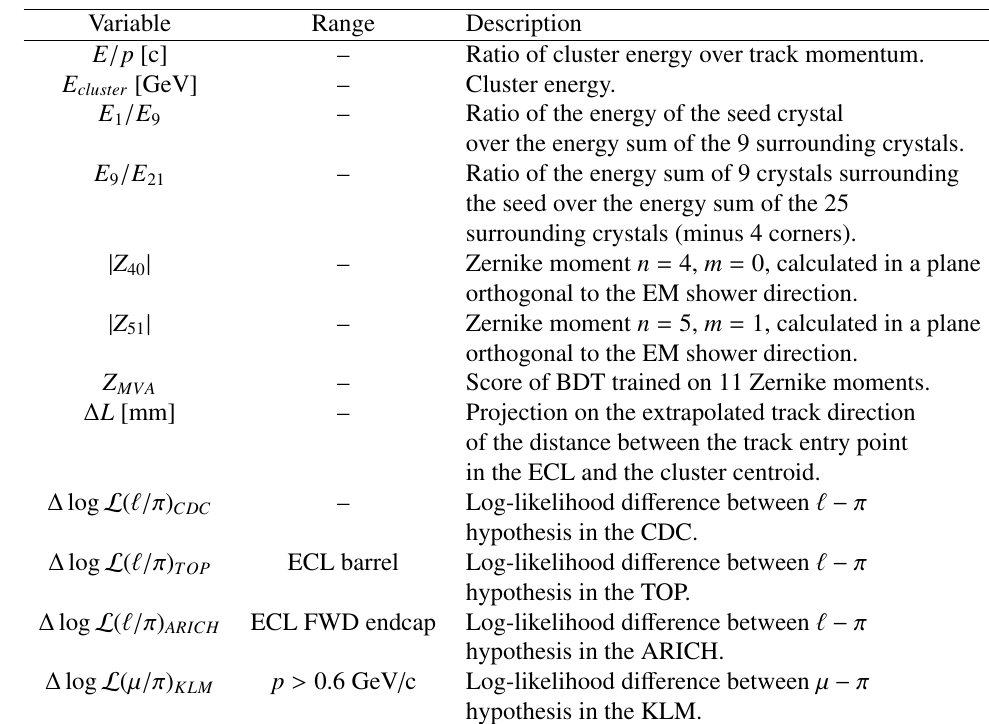
Table 1. Description of the input variables for the e / π , µ/π BDTs. The “Range” field indicates whether a variable is defined only in a particular subset of the selected phase space region.